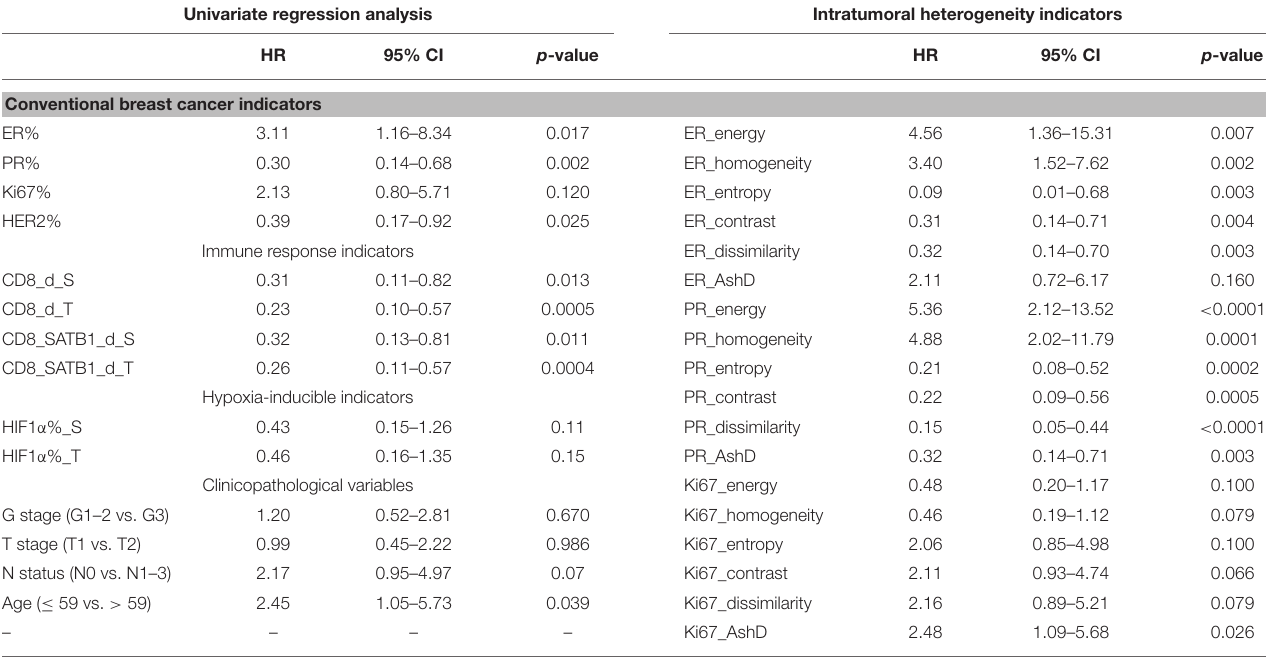
TABLE 2 | Kaplan-Meier estimates using log-rank test for overall survival in relation to IHC, intratumoral heterogeneity and clinicopathologic indicators. Univariate regression analysis Intratumoral heterogeneity